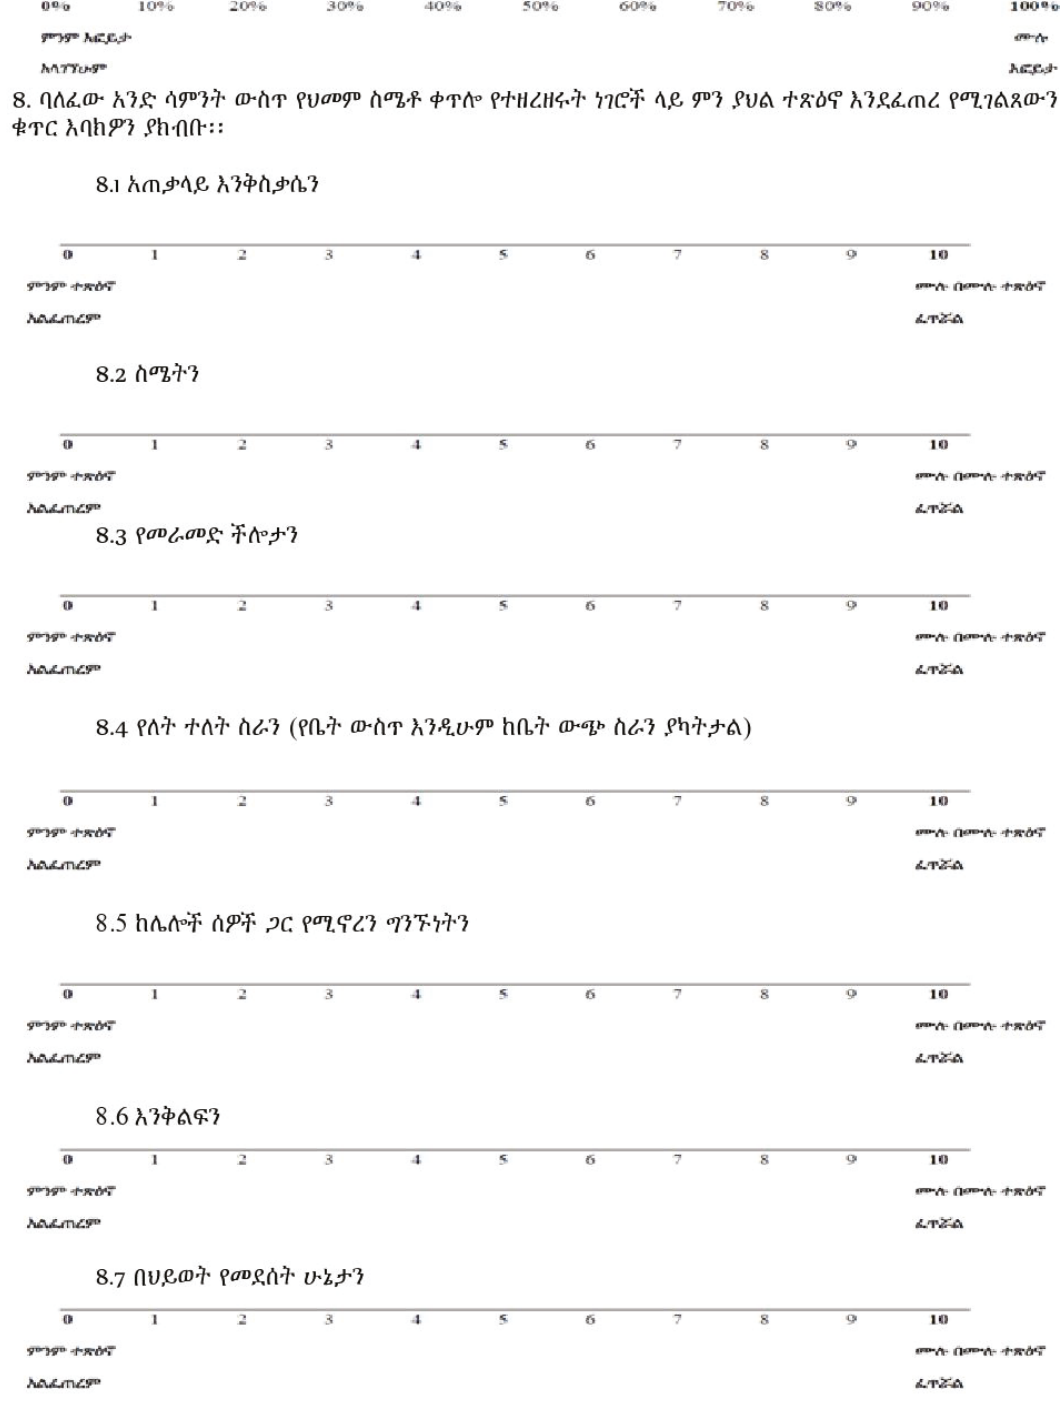
Figure 6: Amharic version of the